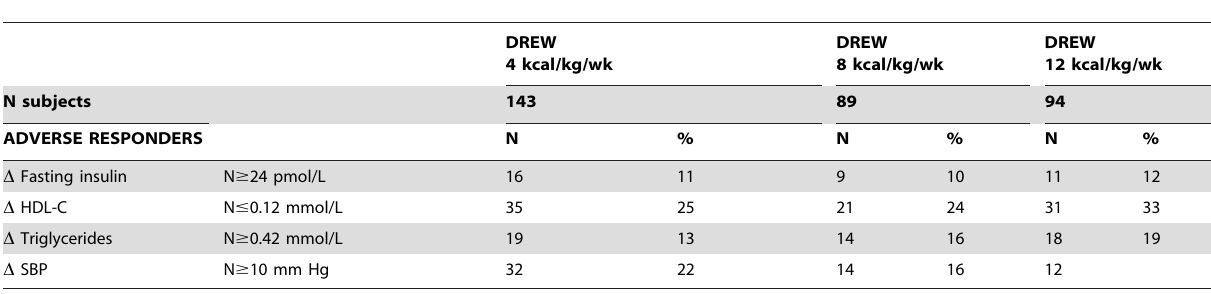
Table 7. Adverse and Excellent Responders to Regular Exercise in DREW*.